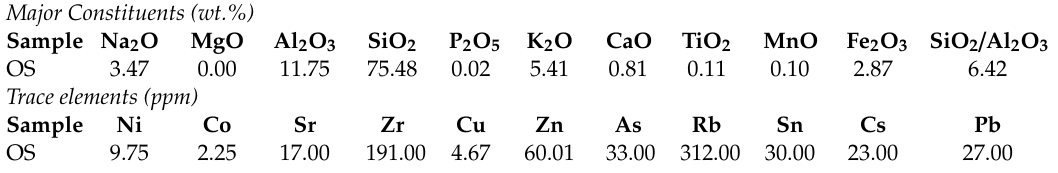
Figure 1. ( a ) X-ray pattern and ( b ) SEM picture of rhyolitic obsidian. Table 1. Chemical composition of obsidian raw material.